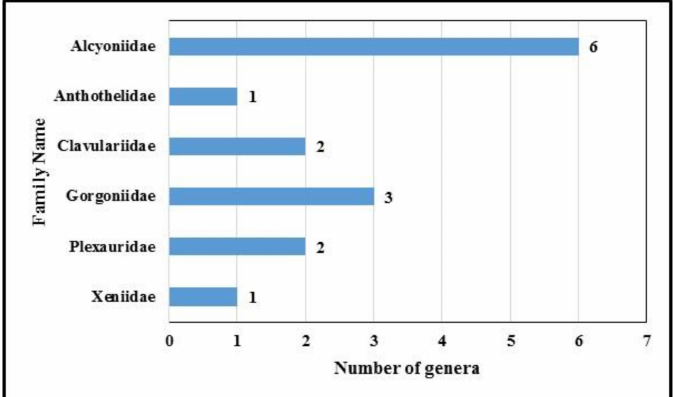
Figure 12. Relationship between Alcyonacea families and genera produce Nitrogen containing